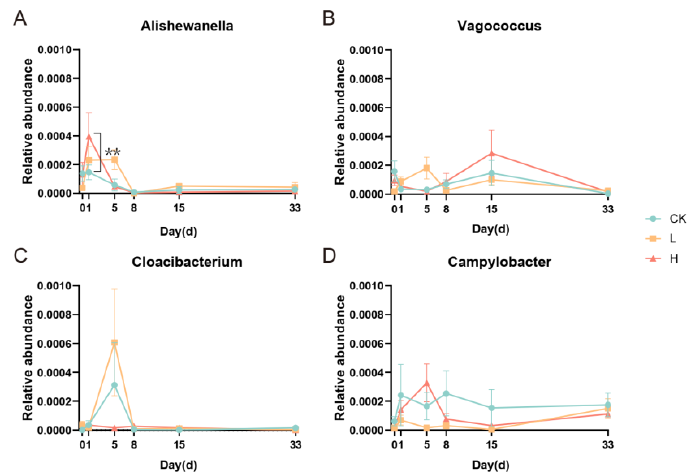
Figure 4. The relative abundance of four bacteria significantly associated with doxycycline concentration (** represents p < 0.01). The four bacteria were Alishewanella ( A ), Vagococcus ( B ), Cloacibacterium ( C ), and Campylobacter ( D ).